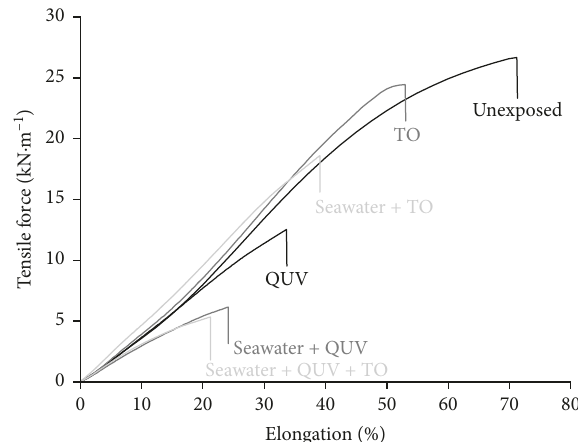
Figure 1: Mean curves “tensile force-elongation” obtained before and after the single and multiple exposure degradation tests.